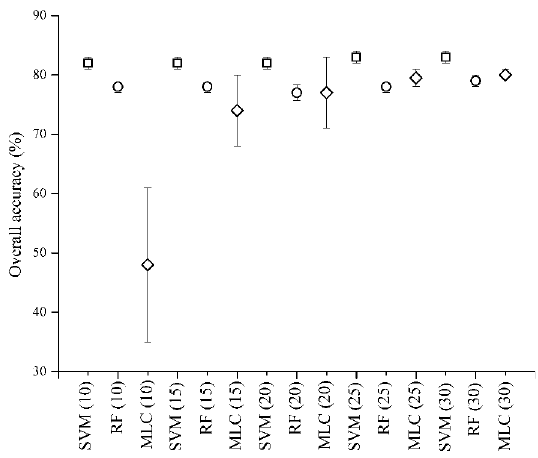
Figure 3. Overall accuracies of SVM, RF and MLC classifiers using nine MNF-transformed bands and different number of random training pixels (N = 10; 15; 20; 25 or 30) from each vegetation